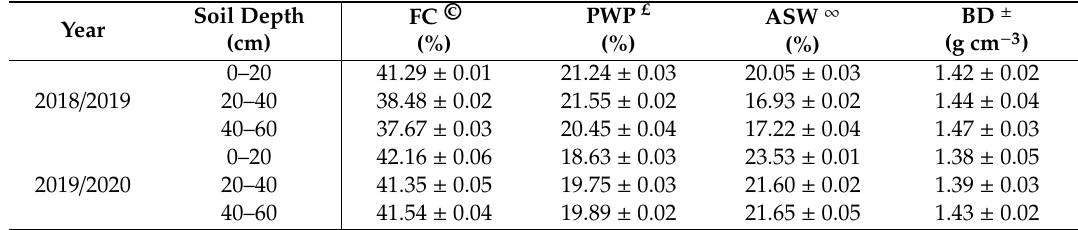
Table 7. Soil moisture constants before planting in the two growing seasons 2018 / 2019 and 2019 /